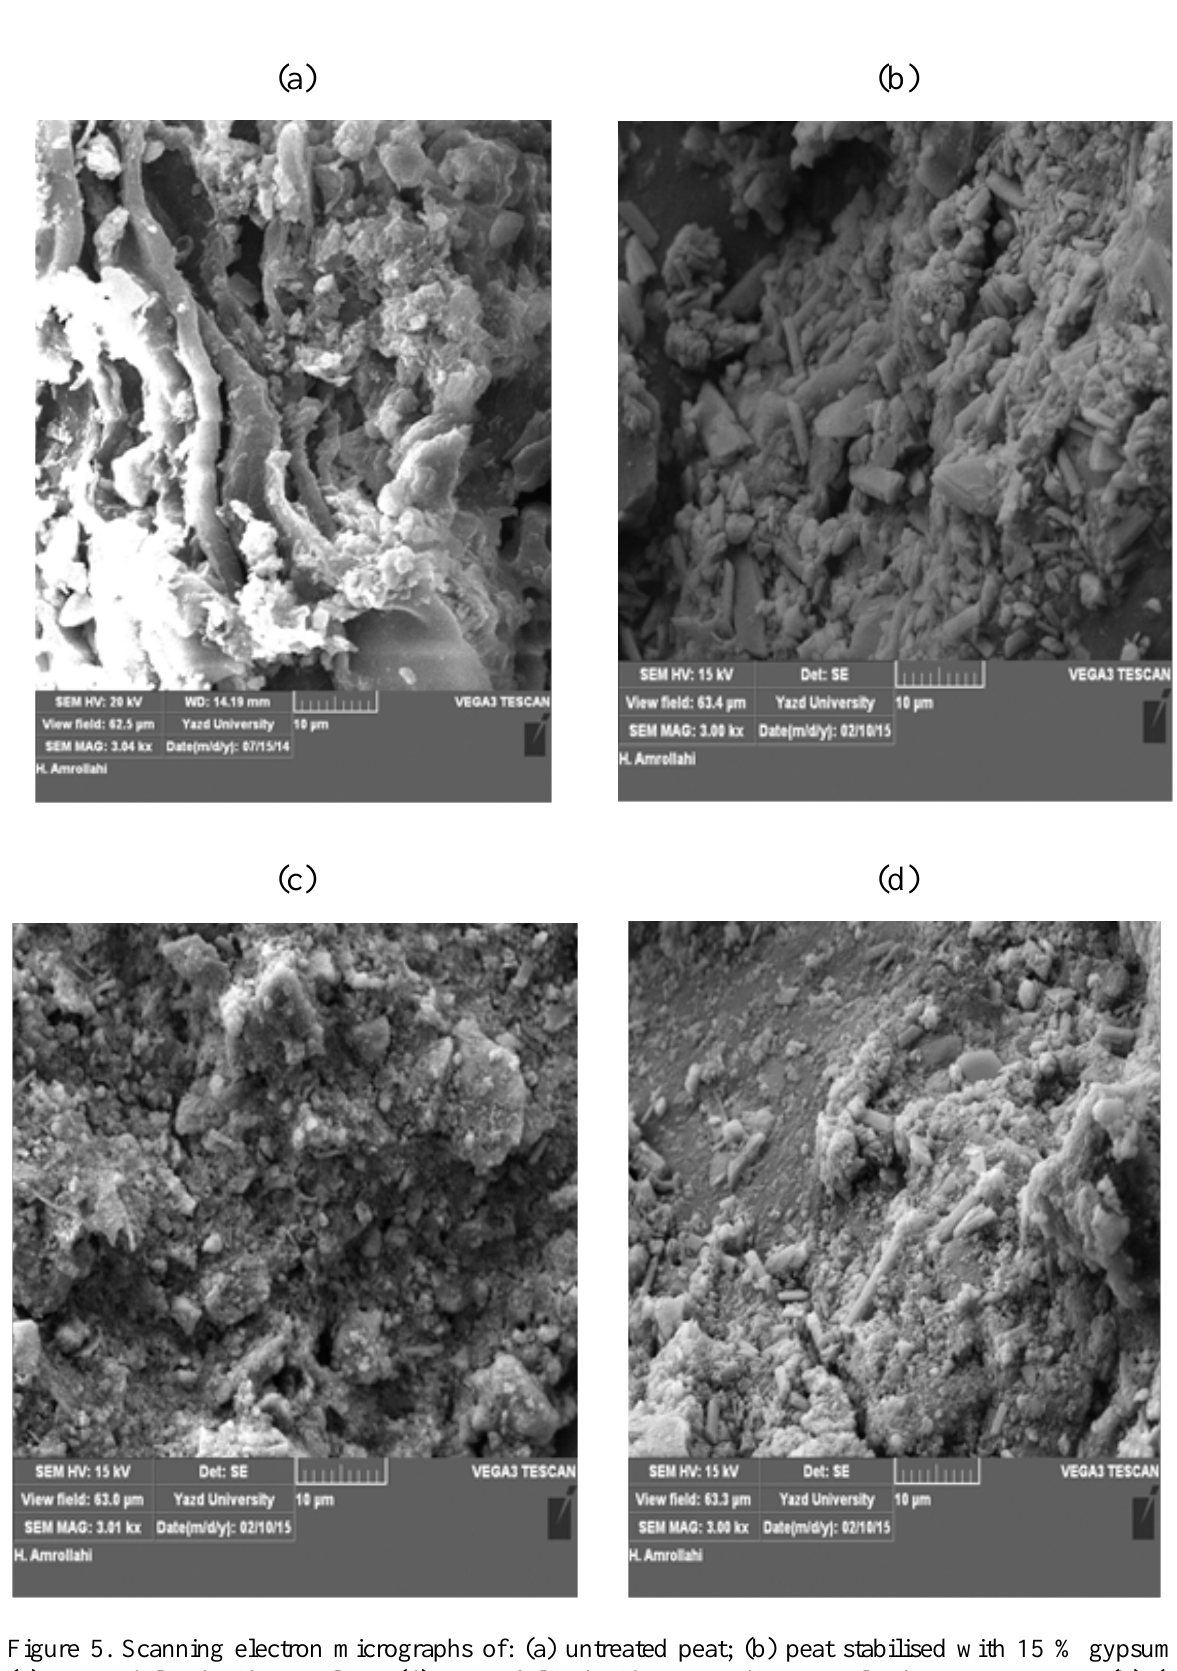
Figure 5. Scanning electron micrographs of: (a) untreated peat; (b) peat stabilised with 15 % gypsum; (c) peat stabilised with 15 % lime; (d) peat stabilised with 15 % ordinary Portland cement. In Cases (b), (c) and (d), sand was also added and the curing period was 28